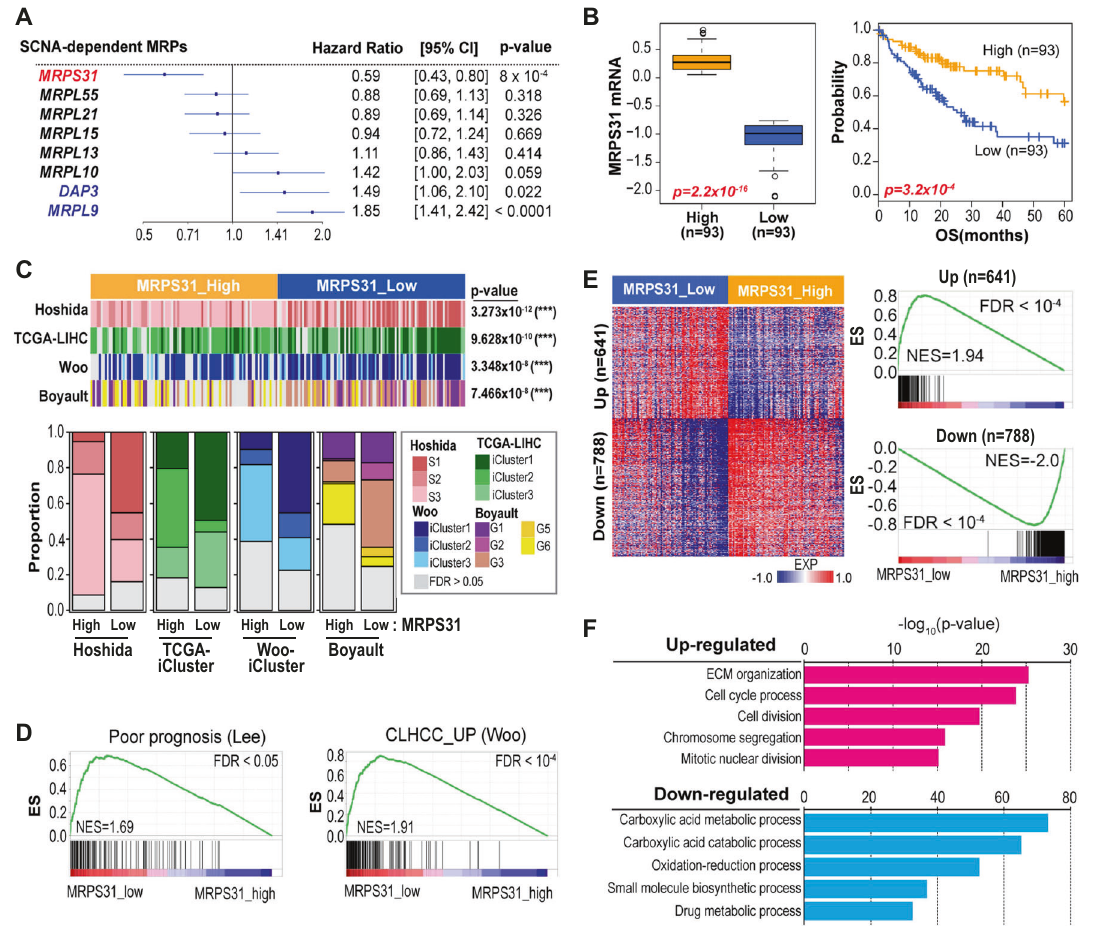
Fig. 2 MRPS31 loss is closely associated with poor clinical outcome of HCC. A Forrest plot of the hazard ratios for the key SCNA-dependent MRPs by the univariate Cox-regression survival analysis. Their con fi dence interval (CI, 95%) and p values are indicated. B Boxplot of MRPS31 mRNA levels (left) and overall survival times (OS) using the KM survival analysis (right). Based on MRPS31 mRNA level, TCGA-LIHC samples were strati fi ed into MRPS31_high ( n = 93) or MRPS31_low ( n = 93) groups (upper or lower quartile). C KM survival curve. Based on RB1 DCN (threshold of − 0.2 for DCN loss), TCGA-LIHC samples were divided into RB1 wild type ( n = 210) and RB1 deleted type ( n = 93) group and then the RB1 wild type group was subdivided into MRPS31_high ( n = 52) and MRPS31_low ( n = 52) groups (upper and lower quartile, respectively). The statistical p value by the Cox-Mantel log-rank test was depicted for (B) and (C) . D Heatmap (top) of HCC classi fi er expressions and proportions of the predicted classi fi ers (bottom) obtained by performing NTP algorithm for the high and low MRPS31 groups. The statistical p values by Fisher ’ s exact test are noted. E Enrichment score (ES) by gene-set enrichment analysis (GSEA) using the Lee ’ s Poor prognosis A (left) and Woo ’ s CLHCC_UP (right) gene-sets. Normalized enrichment score (NES) and false discovery rate (FDR) for each gene set are noted. (F) Expression heatmap (left) and ES plots (right) of up ( n = 641) or downregulated ( n = 788) genes in the high and low MRPS31 groups. NES and FDR for each gene set are indicated. G Barplots of GO analysis using the biological process (BP) gene